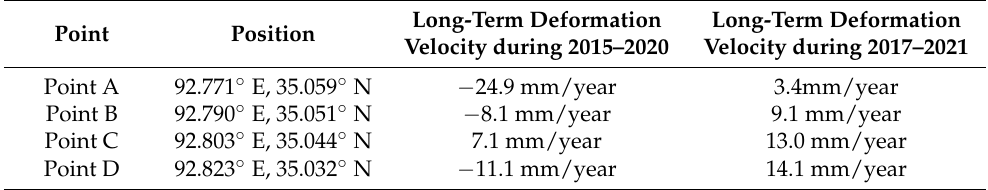
Figure 6. The thermal melting collapse, average deformation and time series deformation of the study points. ( a ) Thermal melting collapse from GF-1/2 during 2019–2020. ( b ) Average deformation rate during 2015–2020. ( c ) Average deformation rate during 2017–2021. ( d ) Time series deformation of points during 2015–2020. ( e ) Time series deformation of points during 2017–2021. Table 5. The details of the four selection